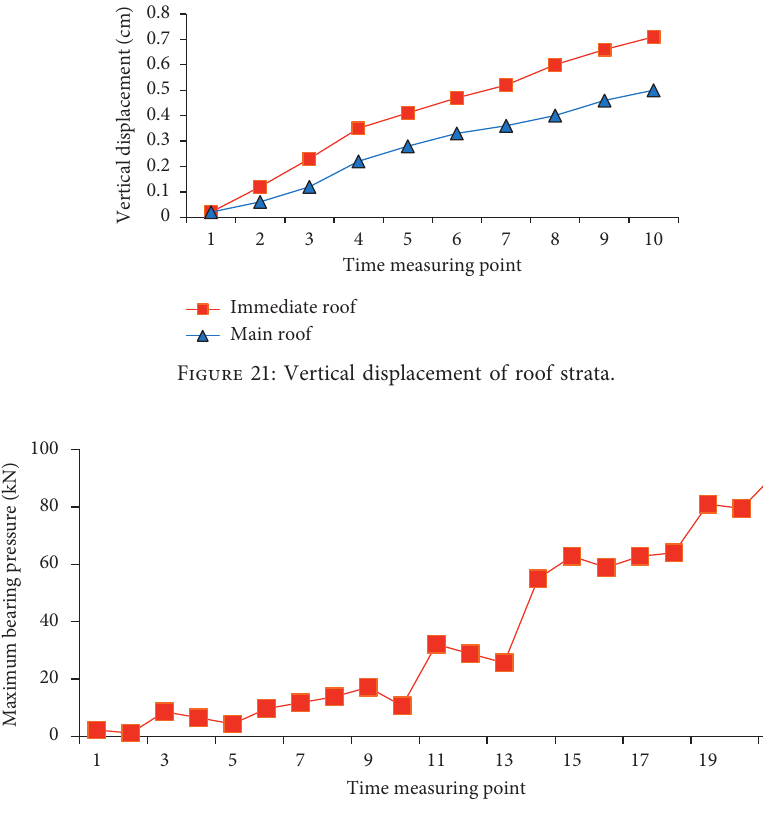
Figure 22: Stress curve of the 5th measuring point on the immediate floor.